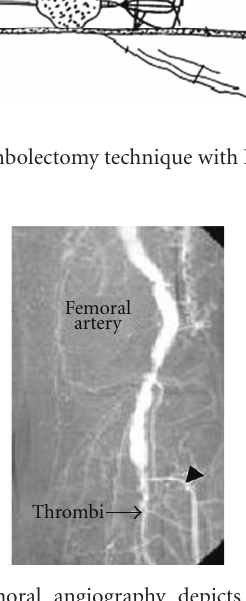
Figure 2: The femoral angiography depicts the right femoral emboli and femoral arterial occlusion.